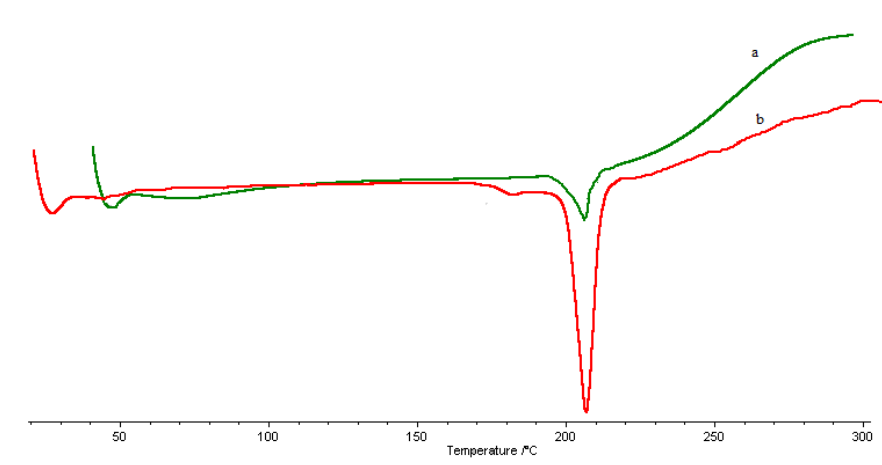
Figure 4. DSC curve of CsACC ( a ), CC ( b ).